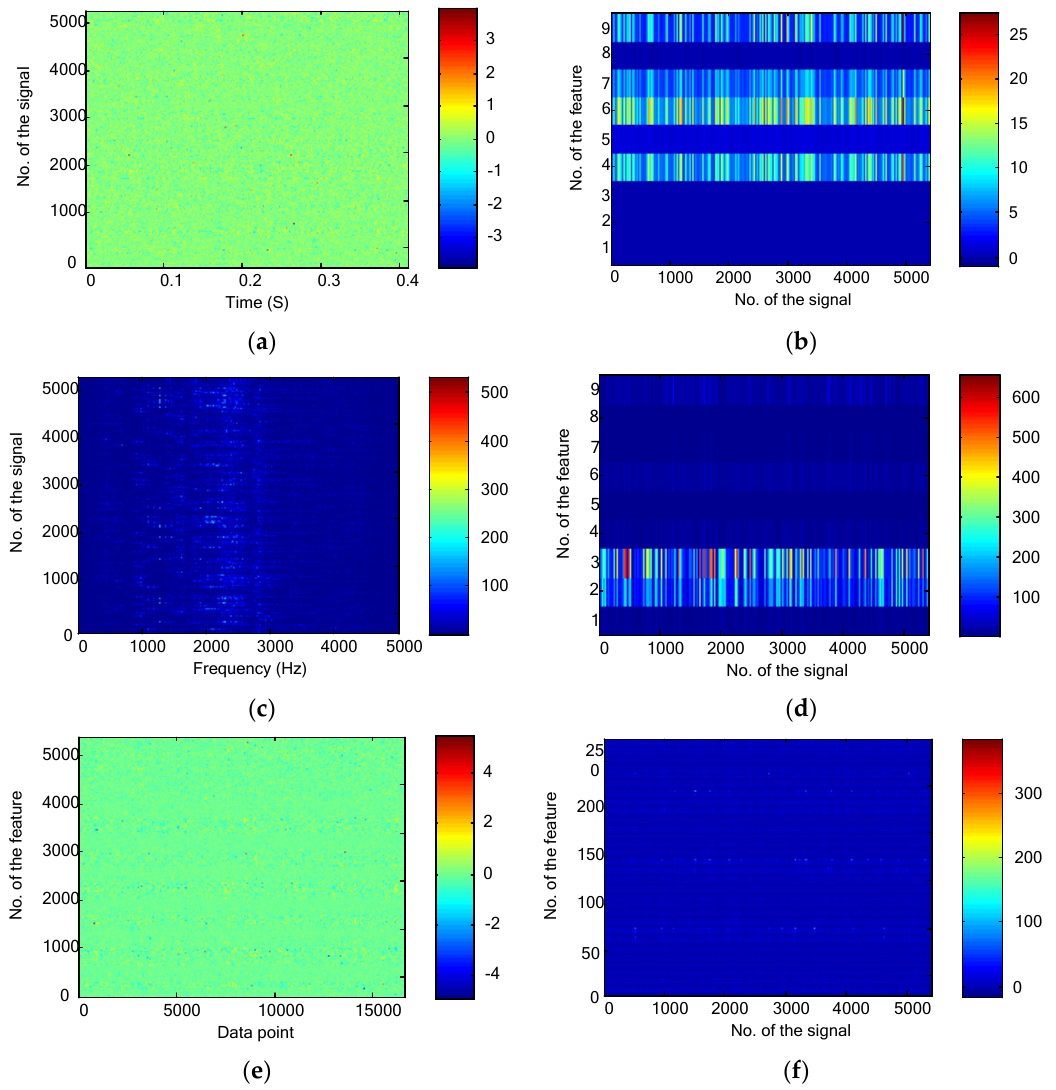
Figure 9. Bearing fault diagnosis experiments: ( a ) the time domain signals, ( b ) the time domain statistical features, ( c ) the frequency domain representations, ( d ) the frequency domain statistical features, ( e ) the WPT results, and ( f ) the time-frequency domain statistical features.